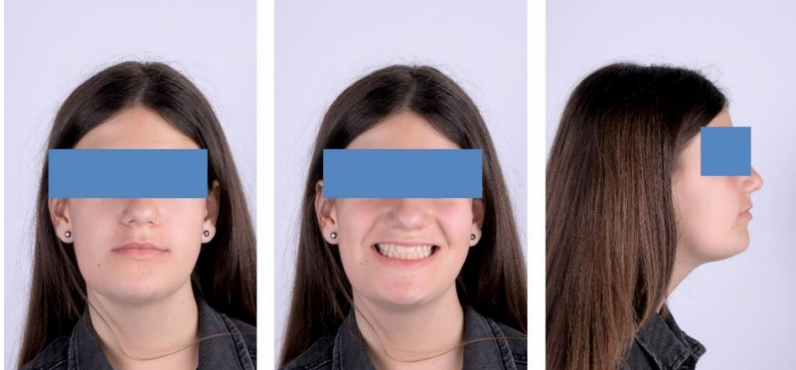
Figure 20. Extra-oral aspect at the end of treatment.